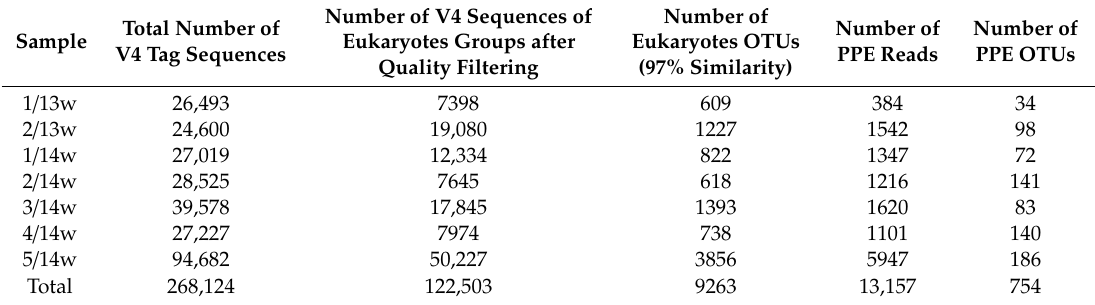
Table 2. Summary of recovered reads and the number of operational taxonomic units (OTUs) in under-ice water picoplankton